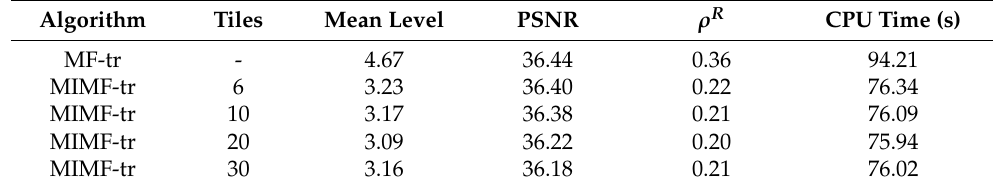
Table 3. Mean levels, PSNR, mean compression rate, and CPU times for the source image in Figure